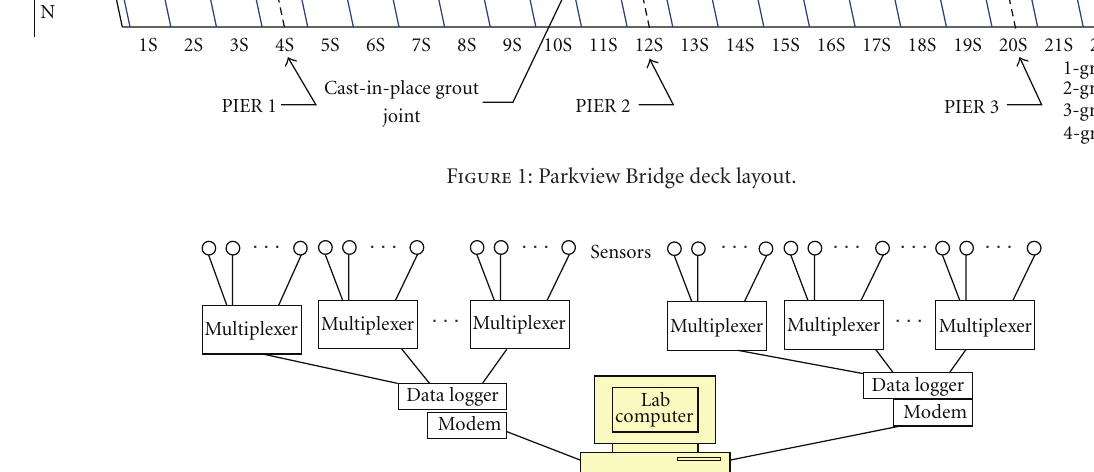
Figure 2: Schematic view of the Parkview Bridge SHM system